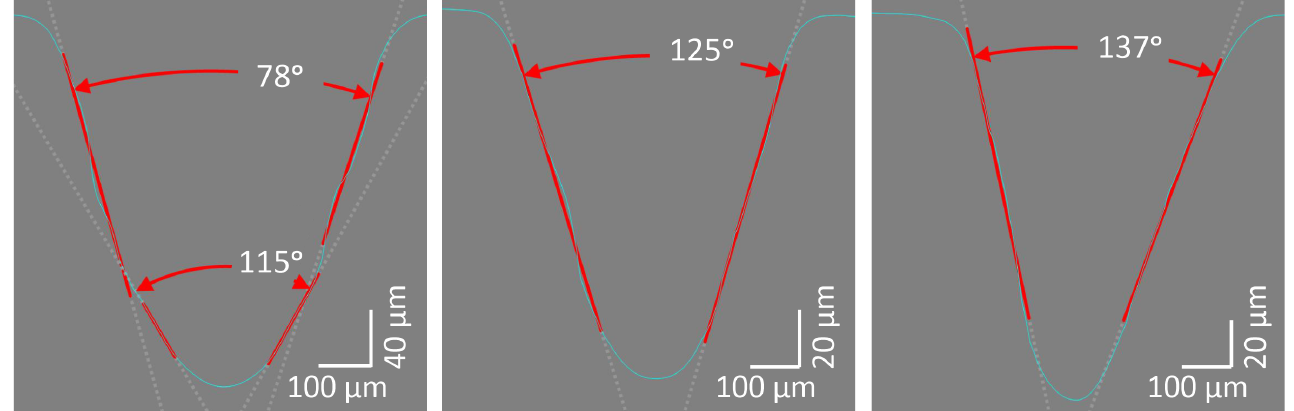
Figure 10. Effect of scan speed: F = 38.1 mm, P = 30 W; ( left ): S = 50 mm/s; ( center ): S = 150 mm/s; ( right ): S = 250 mm/s.